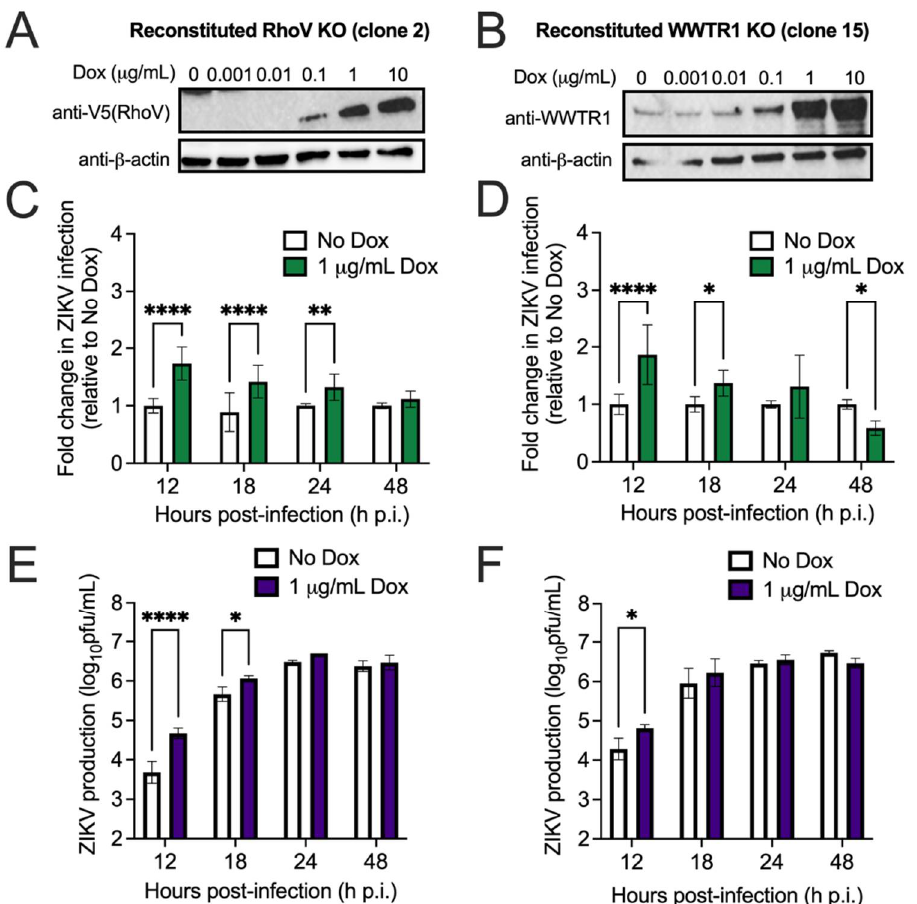
Figure 2. RhoV and WWTR1 enhance ZIKV infection in A549 cells. Reconstituted ( A ) RhoV or ( B ) WWTR1 A549 KO clones were treated with different amounts of Dox (0, 0.001, 0.01, 0.1, 1, and 10 µ g/mL) for 24 h to induce the expression of N-terminally V5-tagged RhoV or WWTR1 through the ePiggyBac transposon system. RhoV, WWTR1, and β -actin (loading control) protein expression was determined by immunoblotting with V5, WWTR1, and β -actin antibodies. The data are representative of two independent experiments. Reconstituted ( C ) RhoV or ( D ) WWTR1 A549 KO clones were treated with or without 1 µ g/mL of Dox for 24 h prior to 1 h adsorption with ZIKV (MOI = 1 PFU/cell) and harvested at 12, 18, 24, and 48 h.p.i. to quantify infection levels. Dox was added back to the media during the course of infection. ZIKV infected cells were then fixed and permeabilized to stain with the pan-flavivirus envelope antibody prior to flow cytometry analysis. Infection levels of cells treated with Dox were normalized to that of the respective untreated condition (no Dox) at each timepoint and reported as fold change in ZIKV infection. The data are combined from three independent experiments. ( E , F ) Supernatant of infected cells from ( C , D ) was collected at 12, 18, 24, and 48 h.p.i. and titered on Vero cells by plaque assay. The data are representative of three independent experiments. Asterisks indicate statistically significant differences (two-way ANOVA and Sidak’s multiple comparisons test: *, p < 0.05; **, p < 0.01; ****, p <